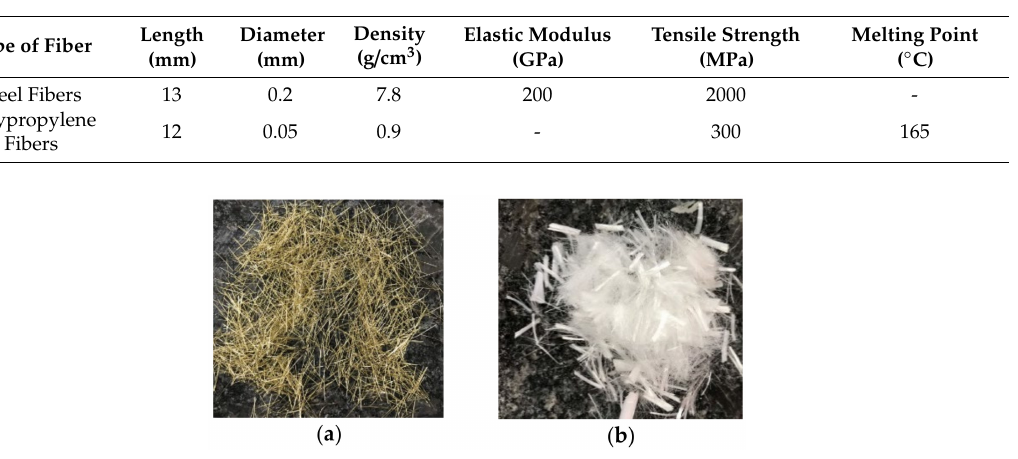
Table 3. Basic properties of fibers.